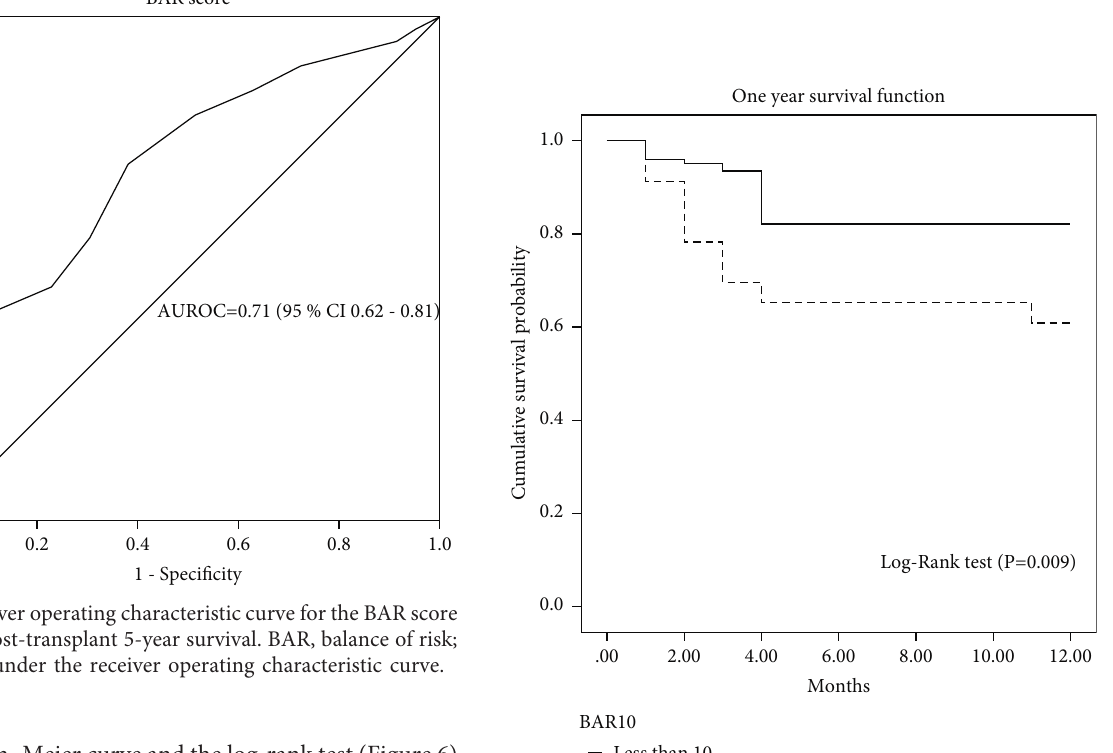
Figure 4: Post-transplant 3-month survival (Kaplan–Meier curve with log-rank test) for patients with the BAR score < and ≥ 10 points. BAR, balance of risk.